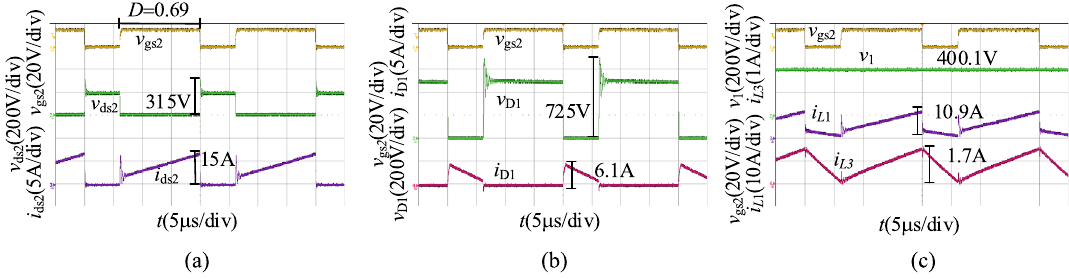
Figure 21. The experiment results of the proposed converter in the step-up mode when v 2 = 60 V: ( a ) v gs2 , v ds2 , i